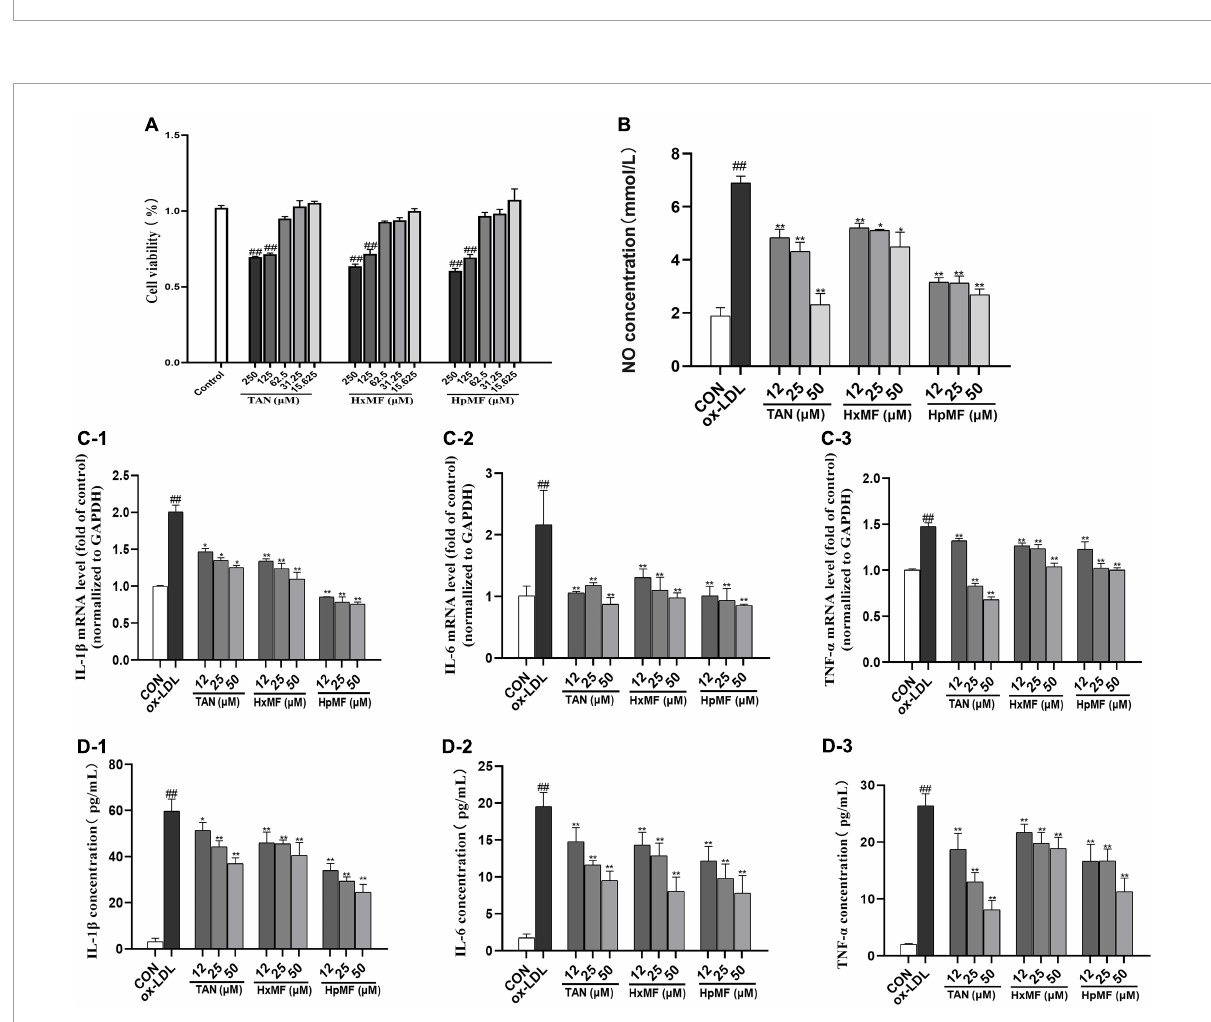
FIGURE2 Cytotoxicity of TAN, HxMF, and HpMF at a series of concentrations on RAW264.7 cells (A) ; effects of TAN, HxMF, and HpMF on ox-LDL-induced production of NO (B) ; effects of TAN, HxMF, and HpMF on ox-LDL-induced mRNA expression of IL-1 β , IL-6, and TNF- α (C1–C3) ; effects of TAN, HxMF, and HpMF on ox-LDL-induced production of IL-1 β , IL-6, and TNF- α in RAW264.7 cells (D1–D3) . All experiments were run in triplicate, and data showed mean ± SD. ## p < 0.01 compared with the control group, * p < 0.05 and ** p < 0.01 compared with the ox-LDL group.